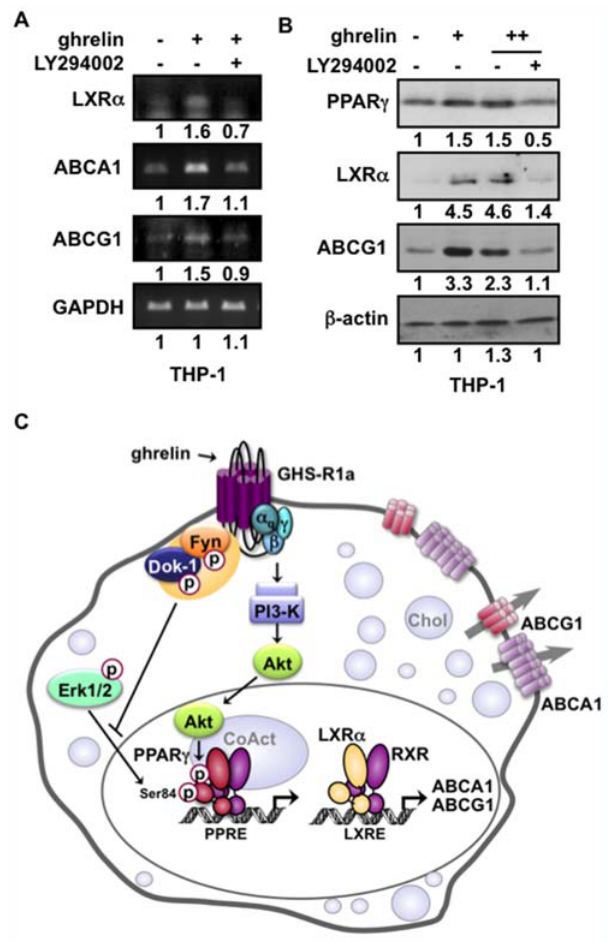
Figure 7. Activation of the PPAR c -LXR a -ABC transcriptional cascade by ghrelin is dependent on the PI3-K/Akt pathway. ( A ) Role of the PI3-K pathway on gene expression analysis from THP-1 cells treated with 100 nM ghrelin and 5 nM LY294002 for 48 h. Represen- tative images and fold changes of mRNA expression are shown for the indicated genes. ( B ) Immunoblot analysis of THP-1 cells treated with ghrelin in presence or absence of 5 nM LY294002 for 48 h. Fold changes are shown relative to untreated cells. ( C ) A proposed model for the GHS-R1a-induced signaling to PPAR c in macrophages. Activation of GHS-R1a by ghrelin promotes the recruitment and activation of a Fyn/ Dok-1 complex with the subsequent decrease in Erk1/2-mediated phosphorylation of PPAR c Ser-84, restraining its inhibitory potential. Ghrelin also activates the PI3-K/Akt pathway through a G a q –dependent mechanism, which then promotes PPAR c AF-1 phosphorylation independently of Ser-84, resulting in receptor transcriptional activation and increase in the PPAR c -LXR a -ABCA1/G1 metabolic cascade in macrophages.